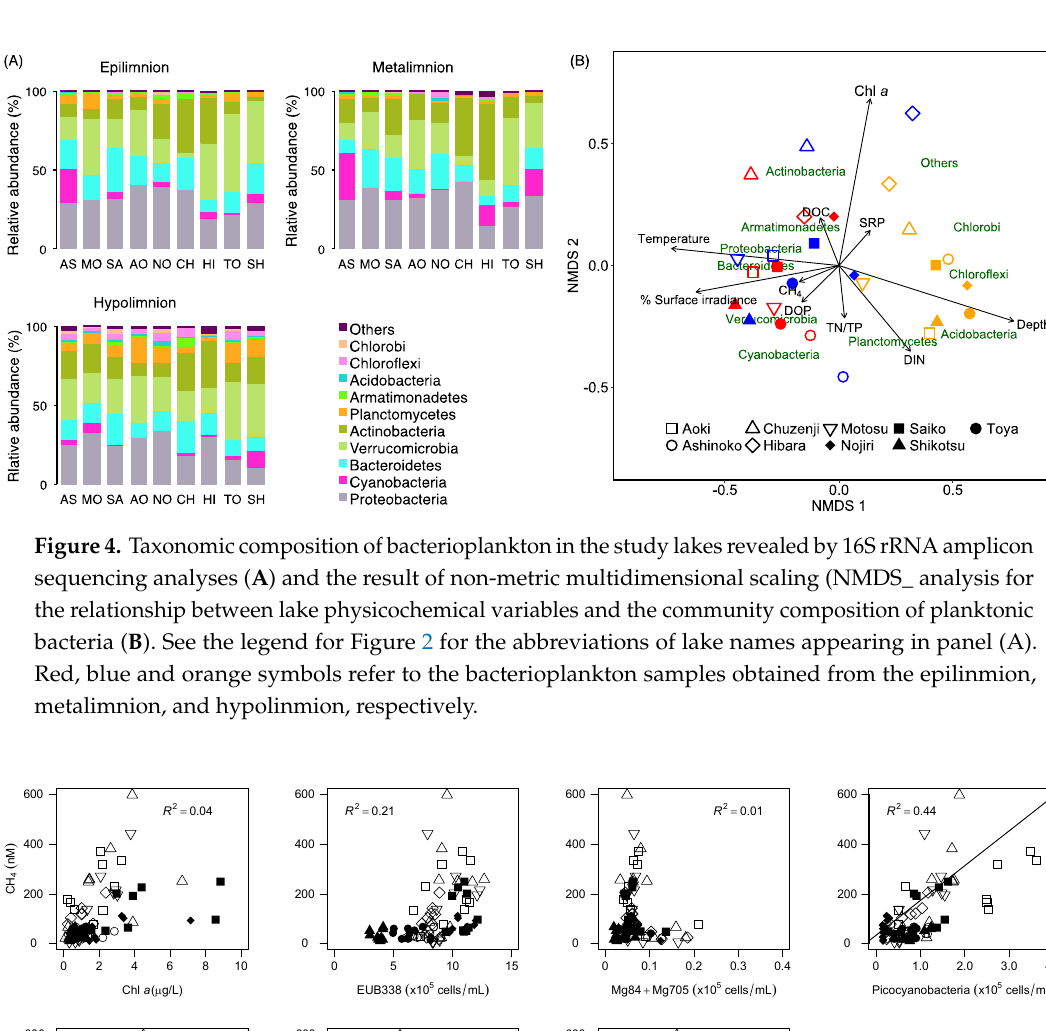
9 of 19 Figure 3. Relationships between dissolved organic carbon (DOC) and chemical variables in the study lakes. Univariate regression lines estimated by the best GLMs with a gamma distribution of the response variable ( y ) are shown. See the legend for Figure 2 for a description of the symbols. 3.3. Community Analyses of Planktonic Algae and Bacteria Microscopic enumeration for eukaryotic algae identified six phytoplankton classes present in the study lakes (Table S7). Among these phytoplanktonic algal groups, Chlorophyceae or Bacillariophyceae predominated in the epilimnion of most of the study lakes except for Lake Toya, where Dinophyceae (53.6%) was the dominant group. Similarly, Chlorophyceae and/or Bacillariophyceae tended to predominate in the algal communities in the metalimnion, although Cryptophyceae and Dinophyceae were relatively abundant in the metalimnion of Lake Ashinoko. In the hypolimnion, Bacillariophyceae accounted for 54%–97% of the relative abundance of algal communities, although Chlorophyceae was relatively abundant in the hypolimnion community of Lake Chuzenji (45.8%). There was no phytoplanktonic algal group that consistently exhibited a metalimnetic peak in terms of relative abundance for any of the study lakes.